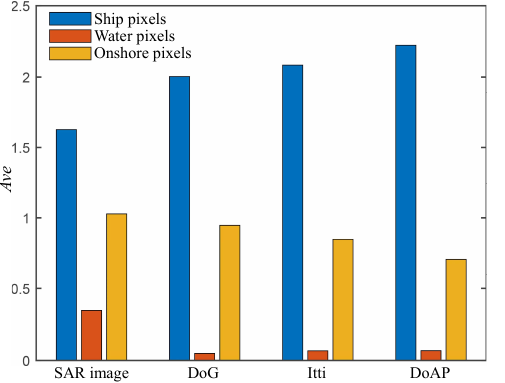
Figure 7. The contrast of ship pixels, water pixels, and onshore pixels.